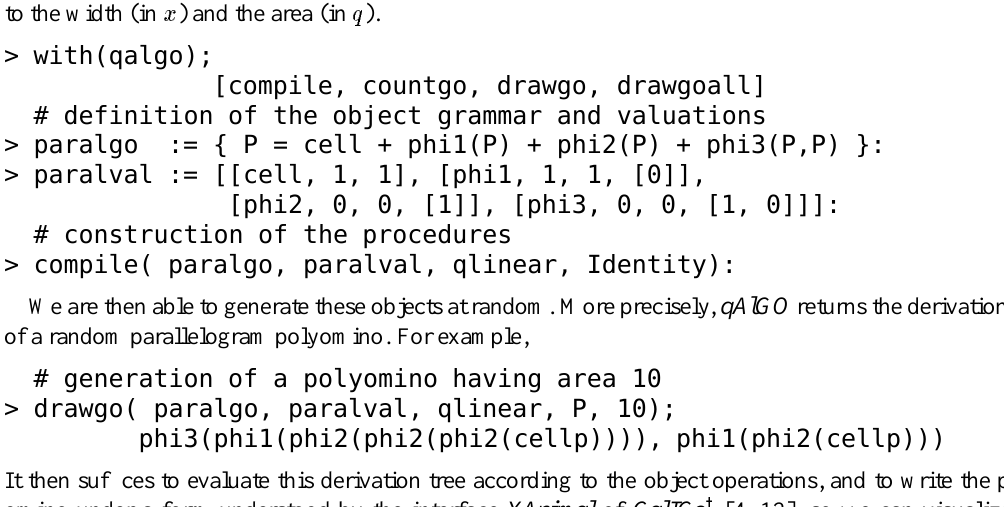
Fig. 7: A parallelogram polyomino of area